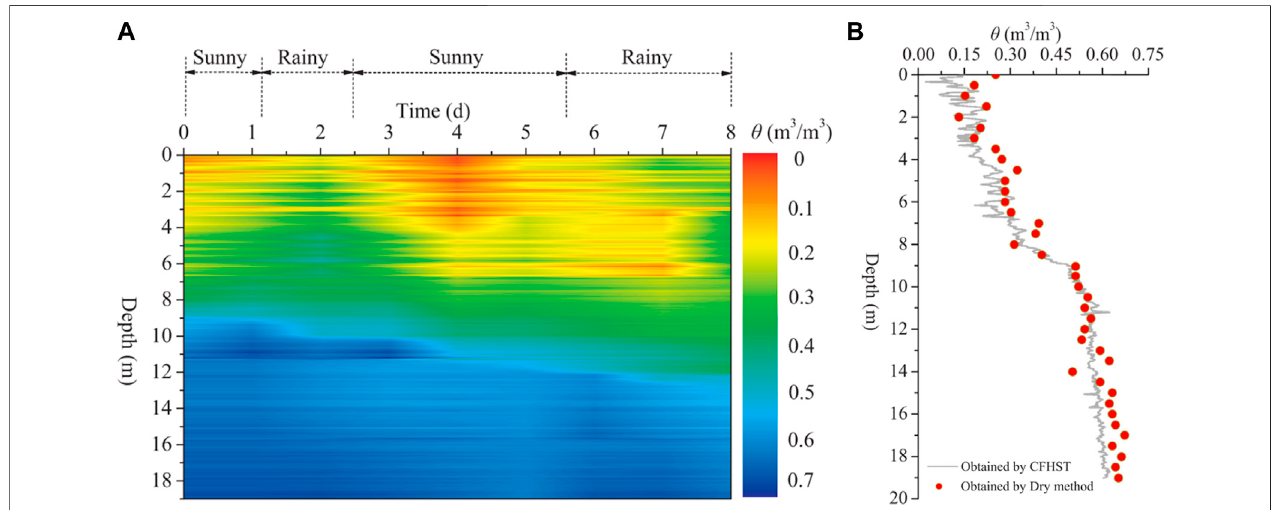
FIGURE 10 | Test results measured by CFHST. (A) Spatiotemporal distribution of soil water content measured by CFHST during the foundation pit dewatering process. (B) Comparison of soil water contents measured by CFHST and the oven-dry method (Cao et al., 2018a).